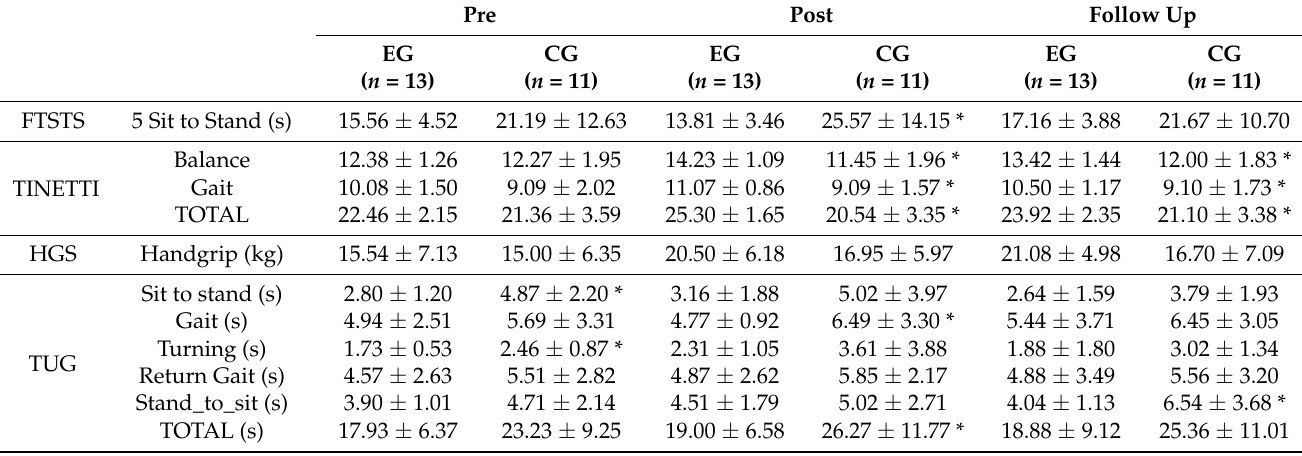
Table 2. Intergroup differences at the 3 evaluation moments (physical and functional